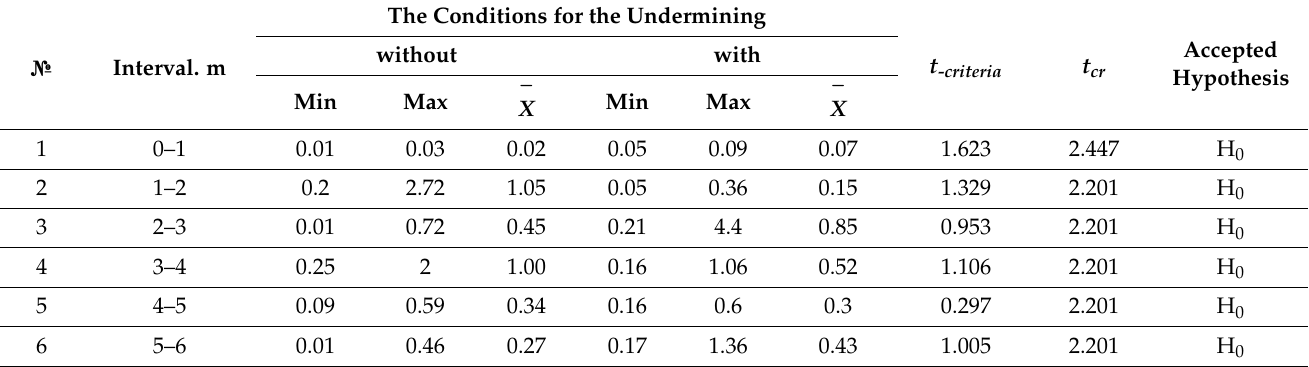
Table 7. The results of the statistical analysis of the experimental studies of the starting gas release of the camera roof.